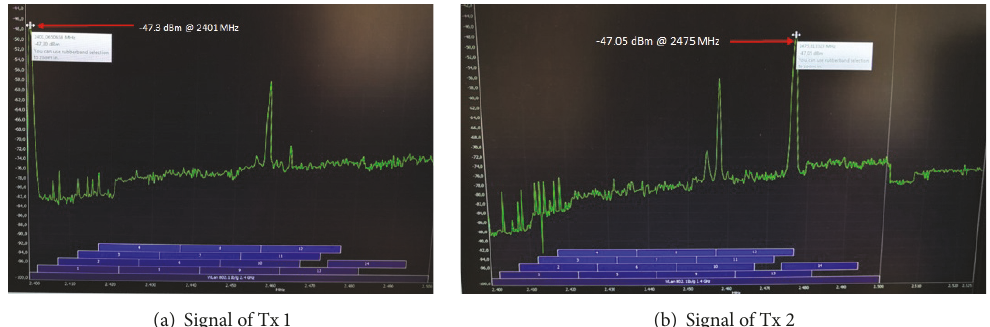
Figure 5: Measurement of the operational frequencies of Tx 1 and Tx 2 by a spectrum analyzer.